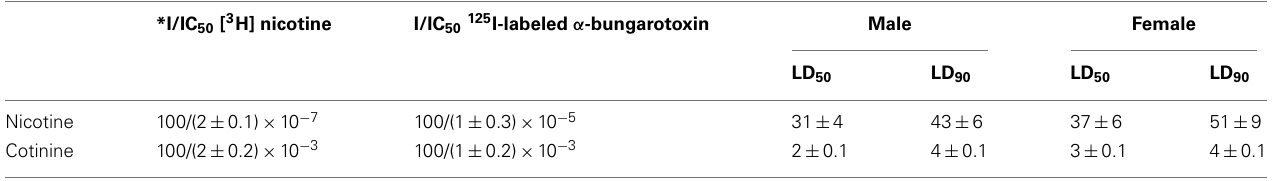
Table 1 | Potencies and affinities of cotinine and nicotine to different subtypes of nAChRs in the rat brain and values of acute toxicity in